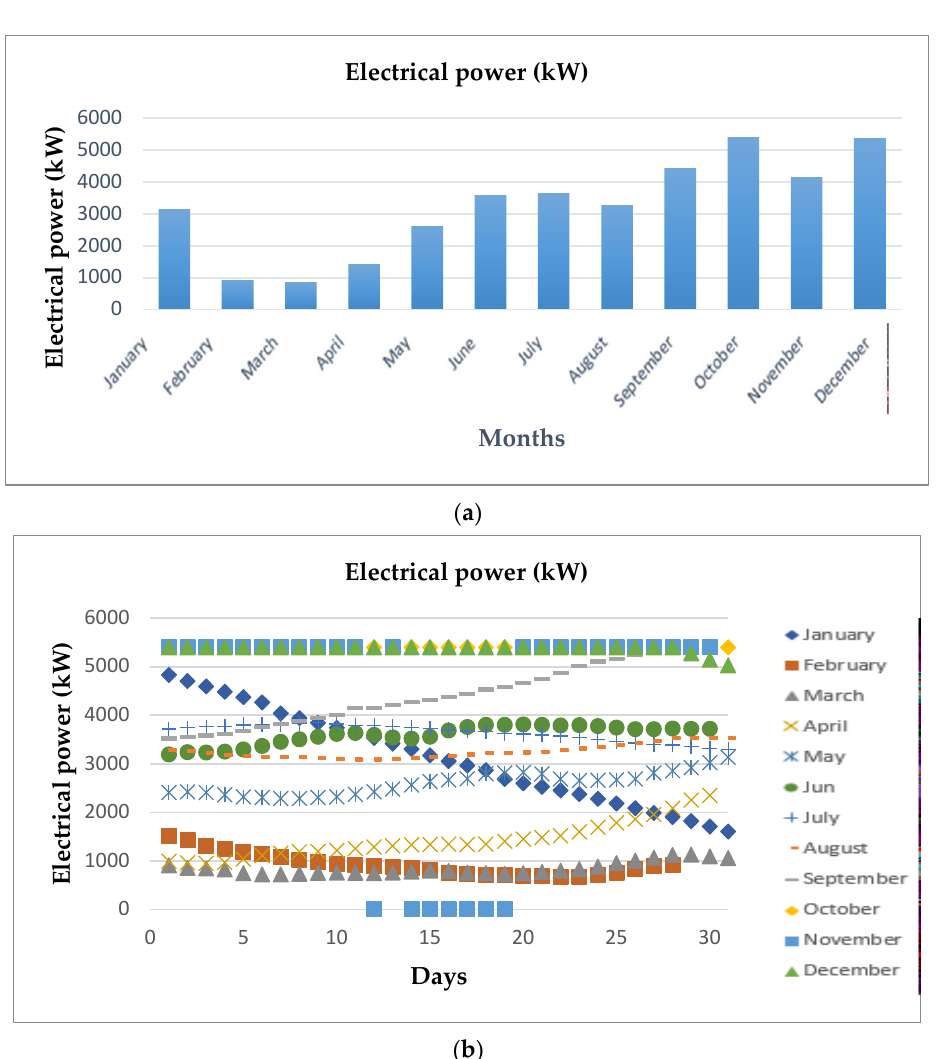
Figure 11. ( a ) Average monthly electrical power histogram and ( b ) average daily electrical power curve.